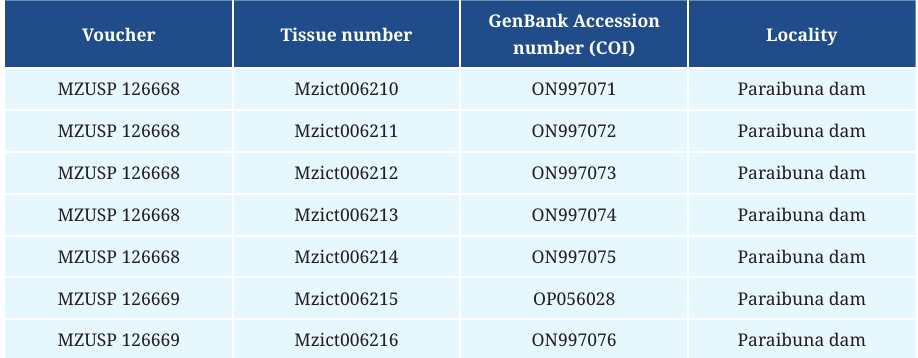
TABLE 1 | Tissue samples of Cyphocharax tamuya used in the present